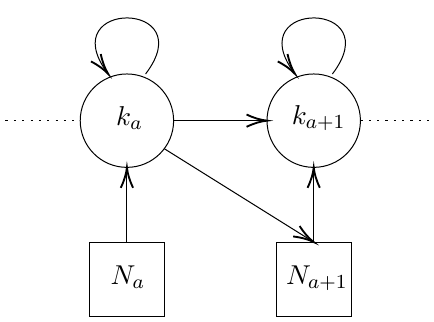
Figure 5. Periodic chainsaw quiver with gauge nodes { k a } and flavour nodes { N a }